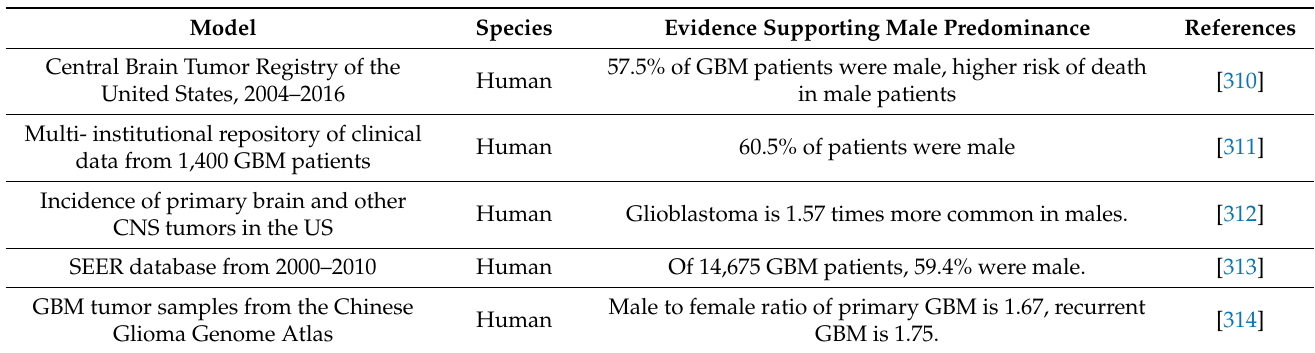
Table 6. GBM is a male-predominant